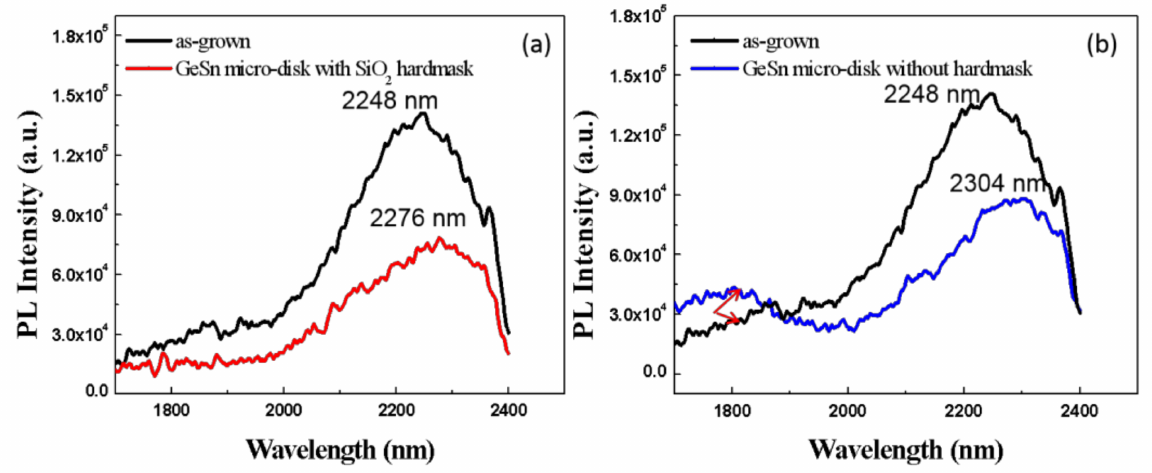
Figure 8. ( a , b ) SEM of GeSn micro-disk with SiO 2 hard mask; ( c , d ) SEM of GeSn micro-disk without hard mask; HRXRD rocking curve of micro-disks for samples ( e ) with SiO 2 hard mask and ( f ) without hard mask; black-colored spectra represent GeSn before etching, and red spectra represent GeSn after etching.